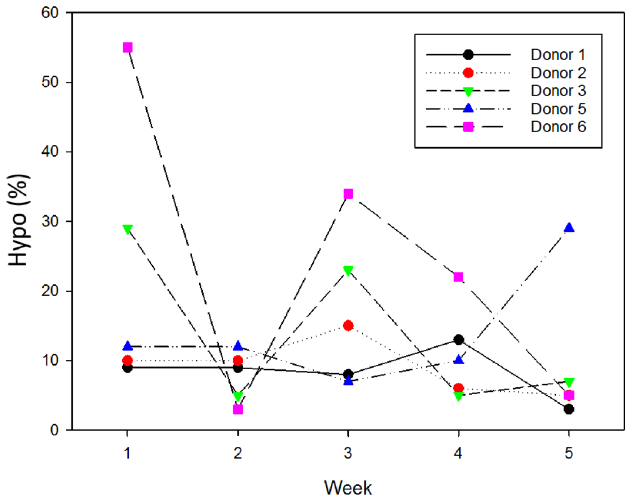
Figure 7. Temporal evolution of the percentage of hypochromic RBCs measured on CTV for all healthy